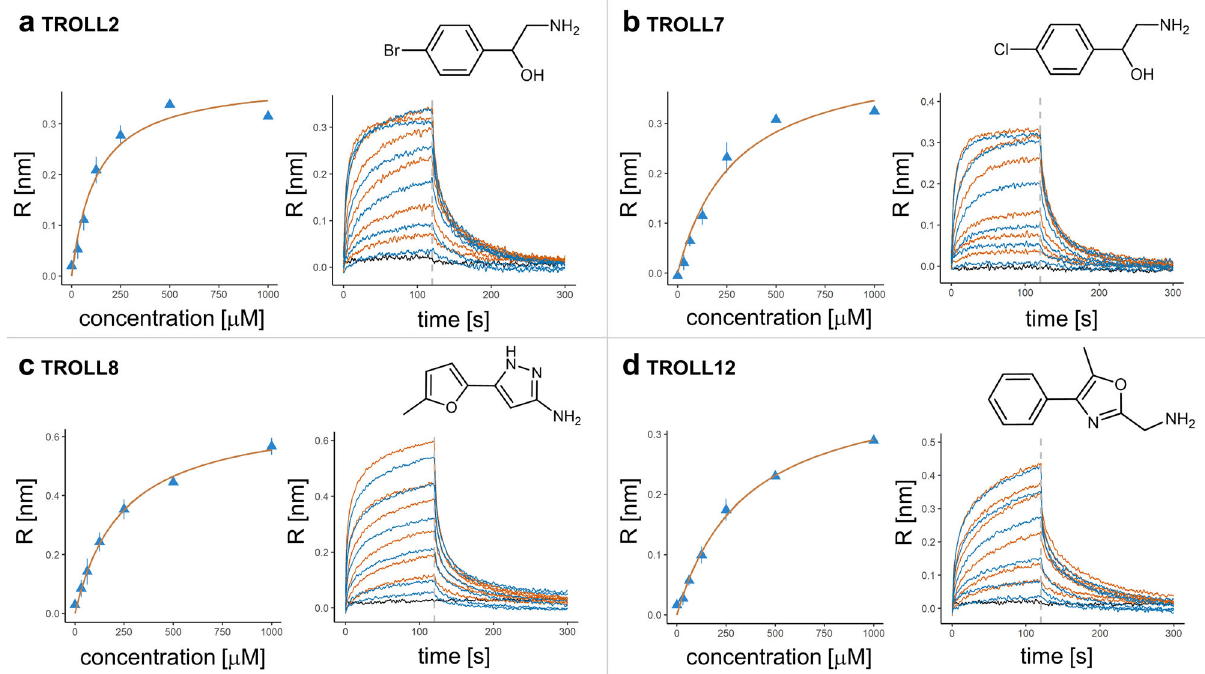
Fig. 2 Sensorgrams and Langmuir models of selected fragments. Results of the dose-response analysis of selected N-domain hits. For each fragment ( a – d ) the obtained shifts are plotted against the fragment concentration, with the fi t to the Langmuir model shown in orange. Every concentration was measured twice and both values were used for fi tting (with bars indicating the range of the two data points). Additionally, the sensorgrams of the fragments are shown after alignment and double referencing ( fi rst measurement: orange; second: blue). The negative control containing assay buffer only is shown in black. The dashed lines indicate the start of the dissociation phase. Sensorgrams which did not reach a plateau phase, because of unspeci fi c binding or biphasic curve courses, received a penalty term in the calculated Score BLI (see method description in Supplementary